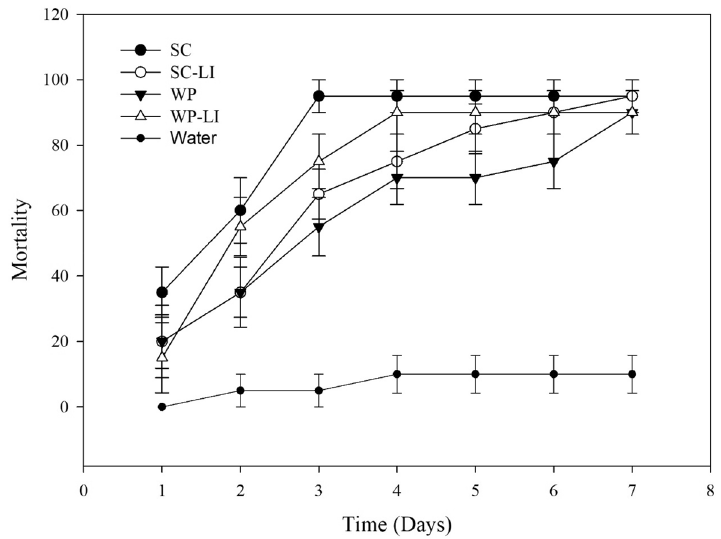
Figure 5. Cumulative mortality of Spodoptera frugiperda caused by LI mixtures and Bt biopesticides in wettable powder (WP) and suspension concentrate (SC). Concentration of 3 × 10 8 spores per